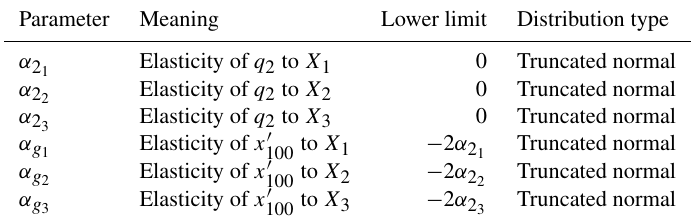
Table 1. Priors of model elasticity parameters controlling the relationship between flood and covariate changes.